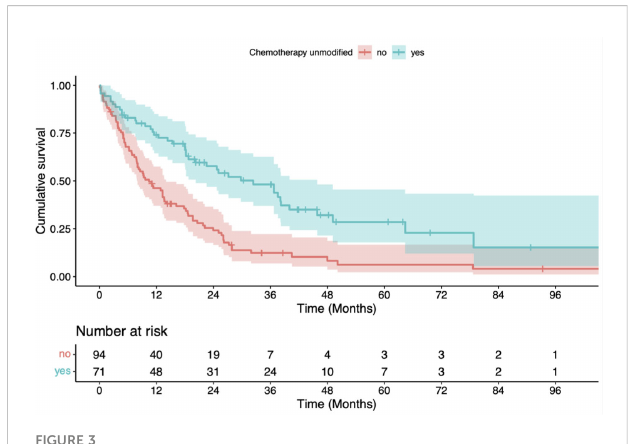
FIGURE 3 Kaplan-Meier estimate of overall survival (OS) after radiotherapy strati fi ed by neoadjuvant chemoradiation followed by surgical resection vs. de fi nitive treatment with (chemo)radiation. OS was signi fi cantly better for patients who received neoadjuvant treatment (p = 0.002, log-rank test).